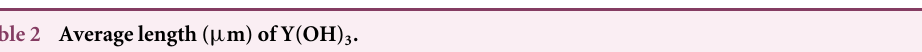
Table 2 Average length ( µ m) of Y(OH) 3